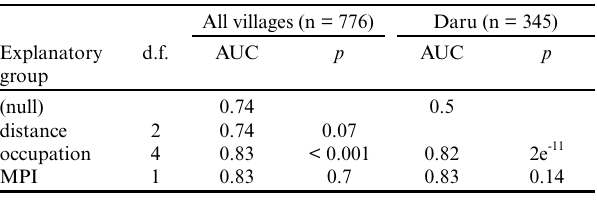
and the trajectories of their social-ecological